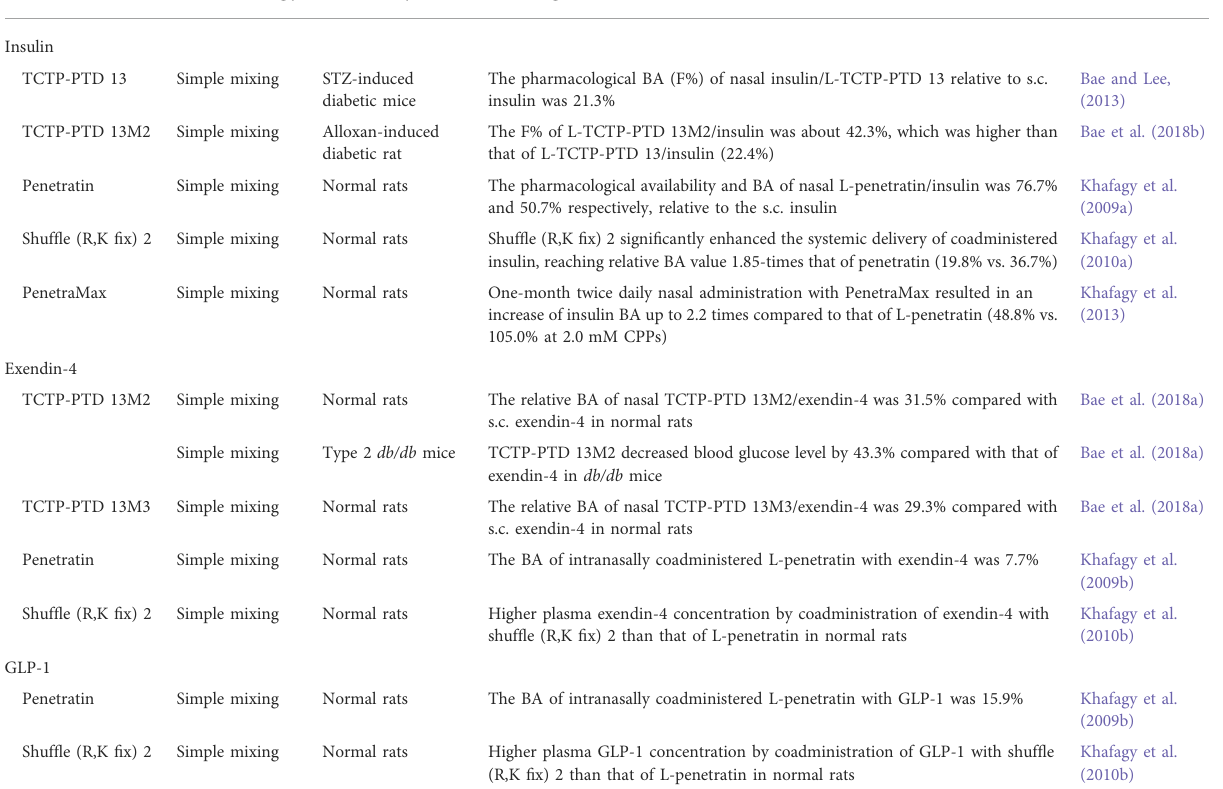
TABLE 2 Nasally delivered systemic antidiabetic peptides using CPPs. Methodology In vivo